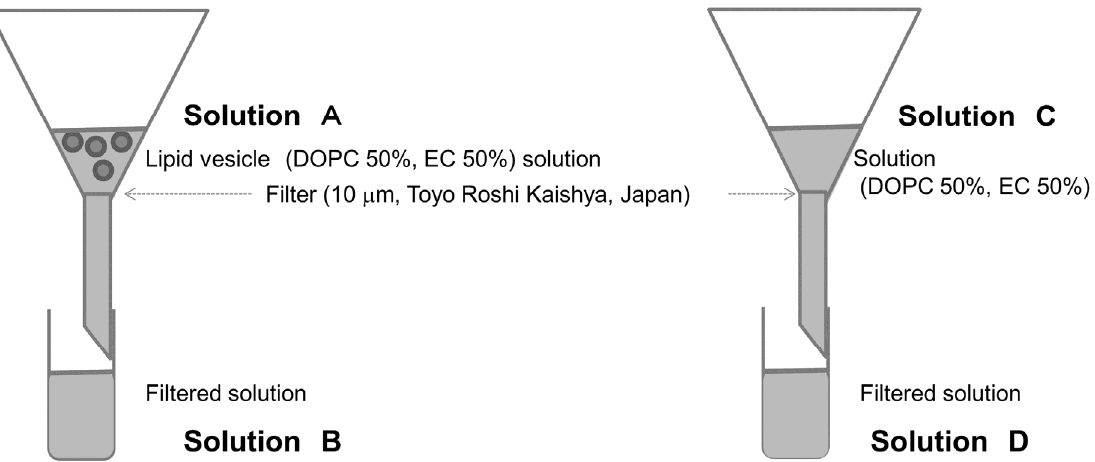
Figure 1. Experiment to confirm presence of EC in membranes using a filter.